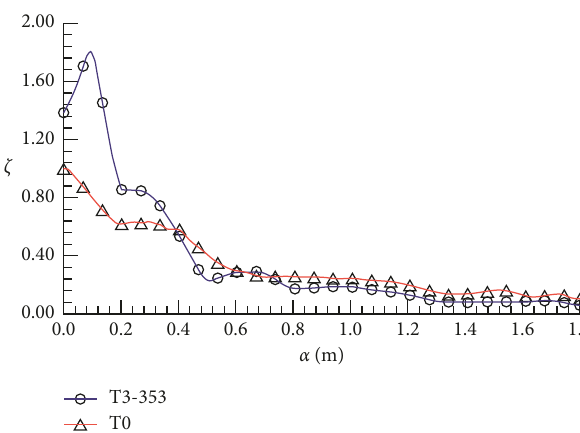
Figure 18: Variation of dissipation rates on L